Question: According to this chart, does the measure grow or shrink?
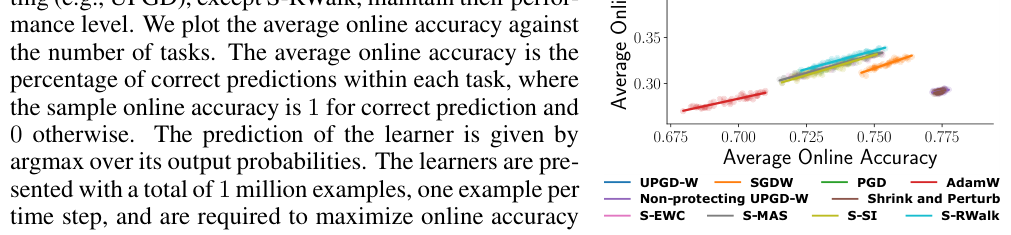
Answer: increasing